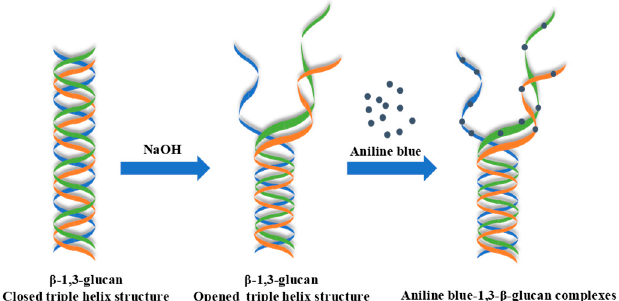
Figure 1. Basic chemical principles of the fluorometric assay for the determination of 1,3- β -glucans.